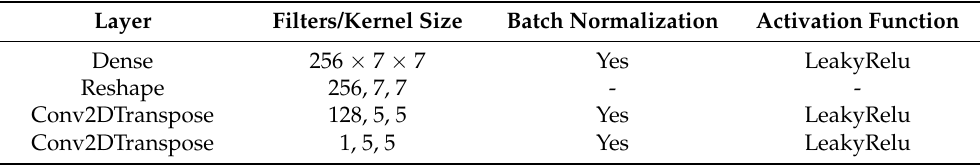
Figure 4. The architecture of the proposed GAN AlexNet. Table 3. The architecture of the conditional map unit (Conv2DTranspose = 2-dimensional transposed convolutional